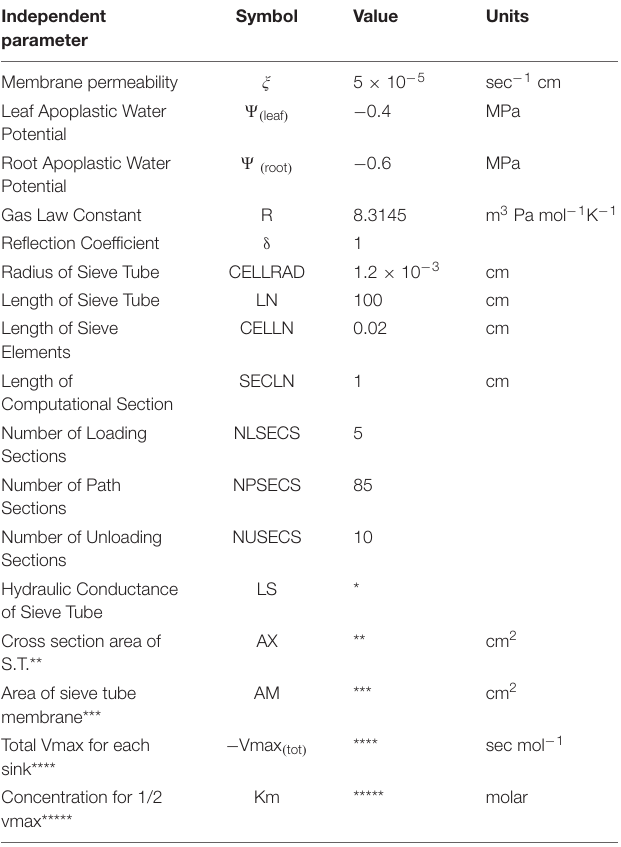
TABLE 1 | Independent and input parameters used in Figure 1 .